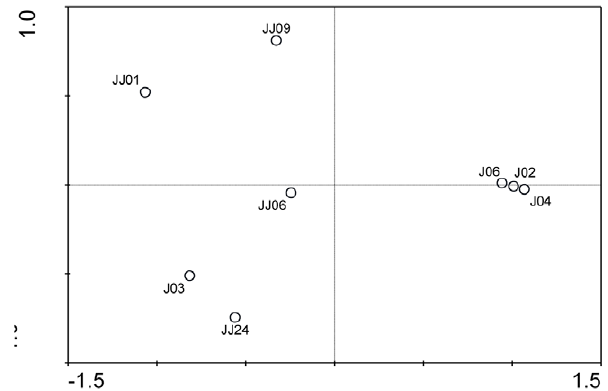
Figure 3. PCA ordination diagram of the anammox communi- ties calculated using 16S rRNA gene sequences from Jiaojiang estuarine sediments. doi:10.1371/journal.pone.0033826.g003 PLoS ONE |